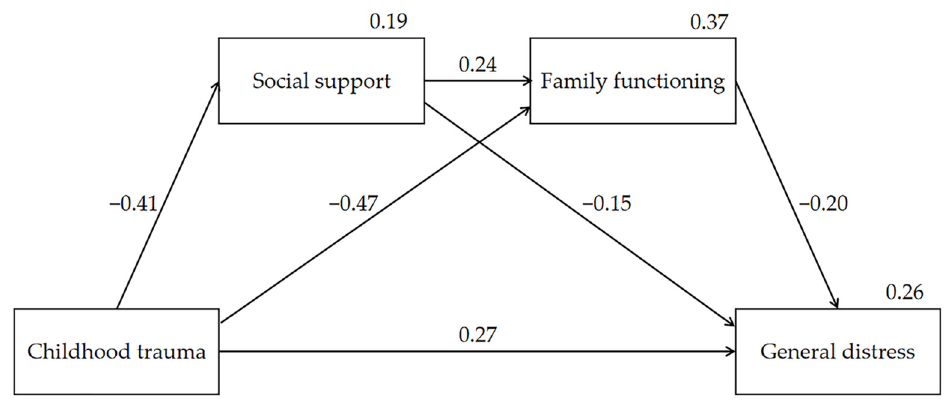
Figure 1. The serial-mediation model showing childhood trauma, social support, and family func- tioning on general distress. Table 4. Total, individual, and serial indirect effects for childhood trauma on general distress and bias-corrected 95% confidence